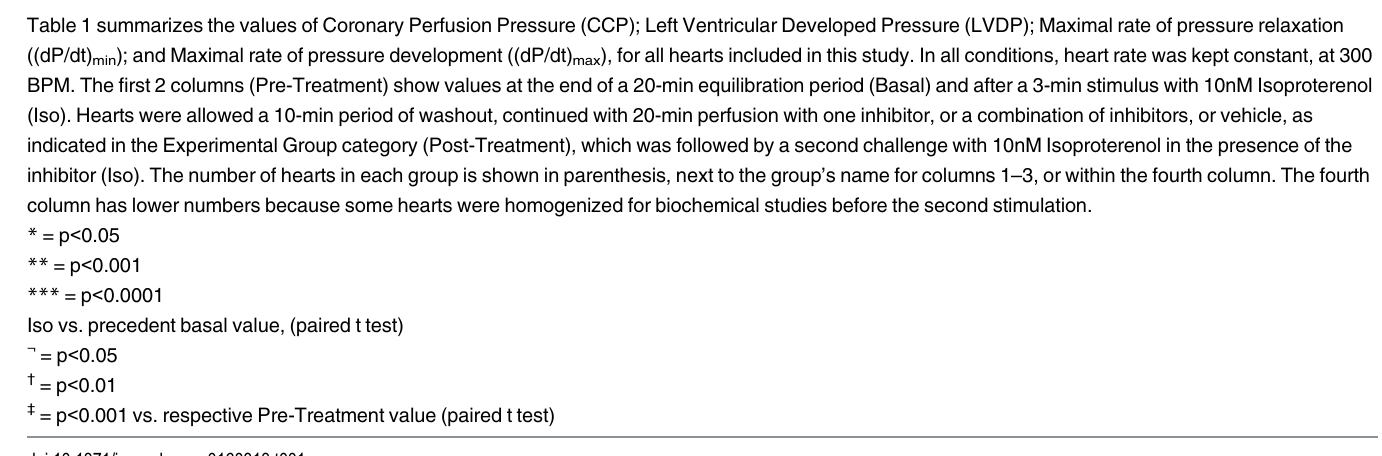
Table 1 summarizes the values of Coronary Perfusion Pressure (CCP); Left Ventricular Developed Pressure (LVDP); Maximal rate of pressure relaxation ((dP/dt) min ); and Maximal rate of pressure development ((dP/dt) max ), for all hearts included in this study. In all conditions, heart rate was kept constant, at 300 BPM. The fi rst 2 columns (Pre-Treatment) show values at the end of a 20-min equilibration period (Basal) and after a 3-min stimulus with 10nM Isoproterenol (Iso). Hearts were allowed a 10-min period of washout, continued with 20-min perfusion with one inhibitor, or a combination of inhibitors, or vehicle, as indicated in the Experimental Group category (Post-Treatment), which was followed by a second challenge with 10nM Isoproterenol in the presence of the inhibitor (Iso). The number of hearts in each group is shown in parenthesis, next to the group ’ s name for columns 1 – 3, or within the fourth column. The fourth column has lower numbers because some hearts were homogenized for biochemical studies before the second stimulation. * = p <